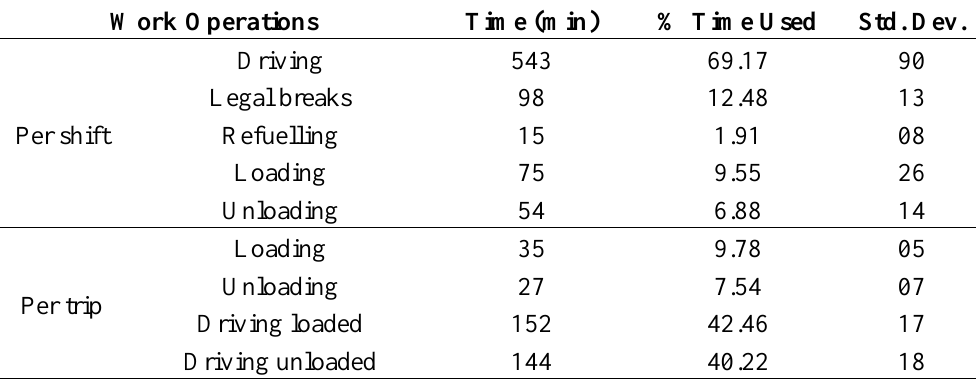
Table 3. Time of different work operations.